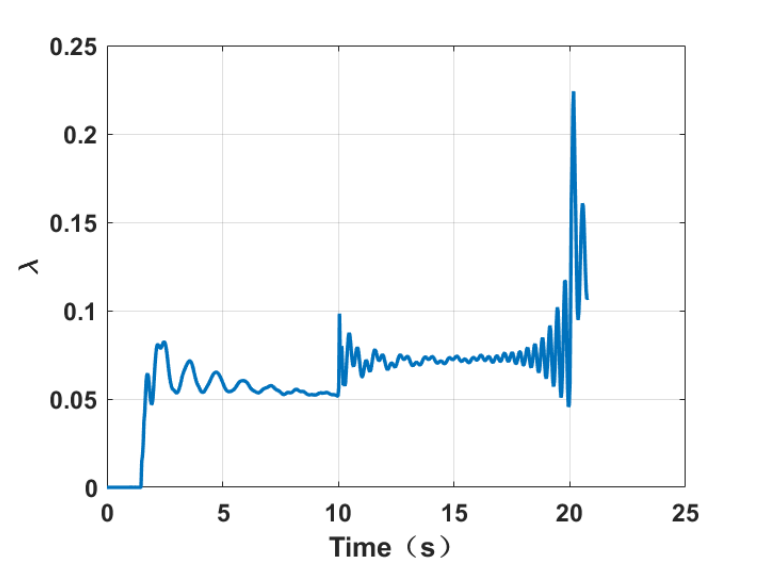
Figure 12. Aircraft slip rate curve on hybrid runway.